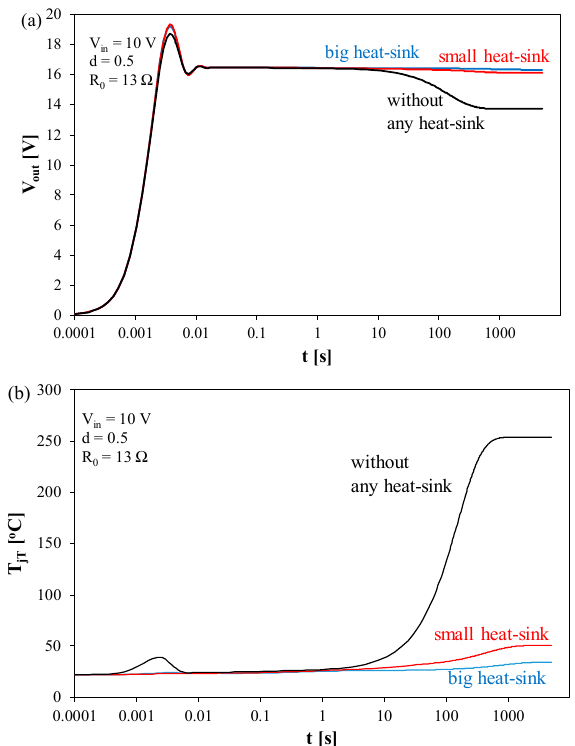
Figure 11. Computed waveforms of: ( a ) the boost converter output voltage at voltage V in of the form of a voltage step, ( b ) the transistor internal temperature.